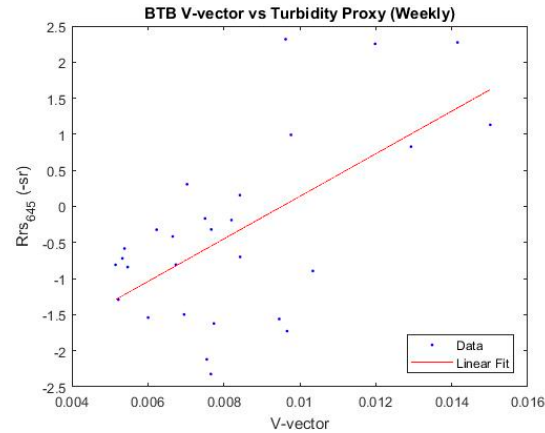
Figure 5. Plot of Barataria Bay weekly XE 95 V-vector vs turbidity proxy anomalies (R 2 adj = 0.355, p = 0.001, n = 28).